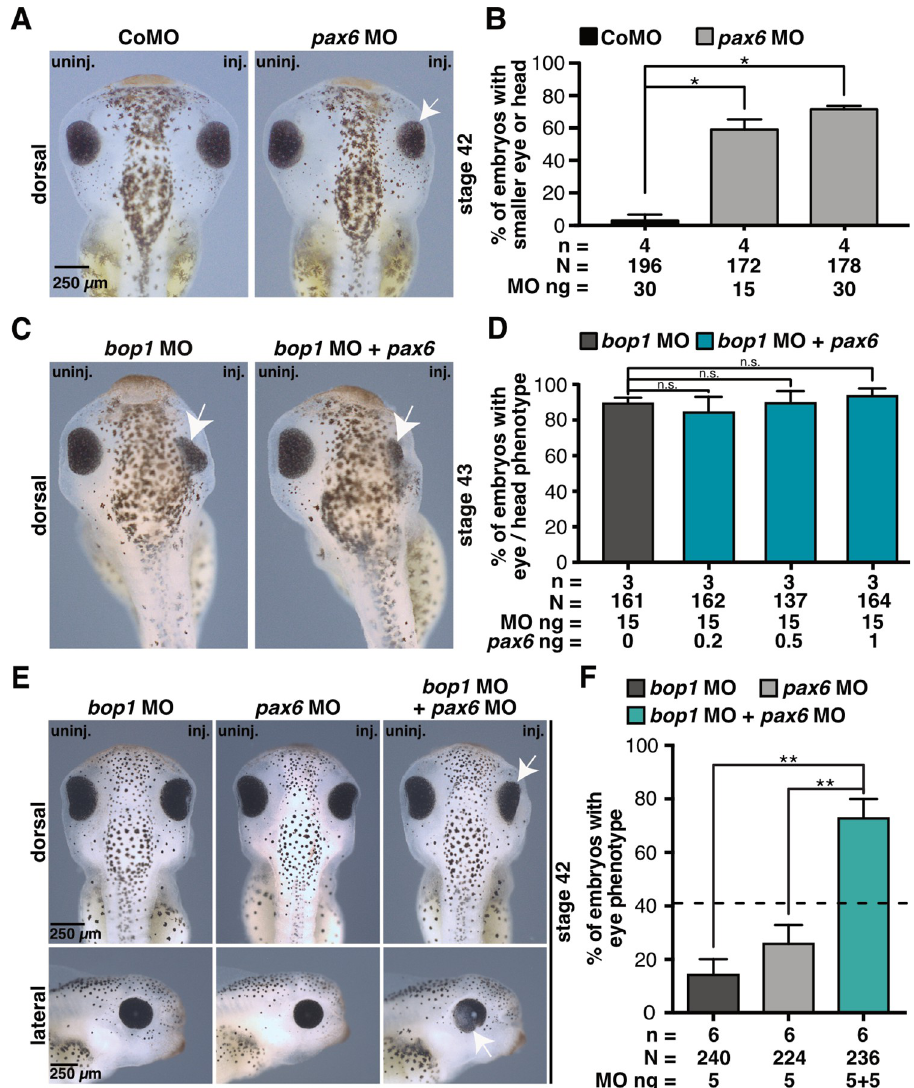
Fig 8. Pax6 and Bop1 act in the same signaling pathway. A Xenopus laevis embryos were injected with 30 ng Control MO and 15 ng or 30 ng pax6 MO at eight-cell stage into one animal-dorsal blastomere. At stage 42, embryos were analyzed regarding a phenotype of the anterior tissue. pax6 MO injection resulted in smaller heads and eyes (white arrows). B Statistical evaluation of data given in A. C Embryos were injected at eight-cell stage with bop1 MO alone or in combination with pax6 RNA. Embryos were fixed at stage 42 and analyzed phenotypically. Smaller eyes are indicated with white arrow. D Injection of bop1 MO alone or in combination with pax6 RNA resulted in severe eye phenotypes. E Injection of 5 ng bop1 MO or 5 ng pax6 MO led to a mild eye phenotype in 15% and 27% of the embryos, respectively. The co-injection of both 5 ng bop1 MO and 5 ng pax6 MO resulted in a severe eye phenotype in a more than additive manner (73%). F Statistical analysis of data given in E. Black dotted line indicates sum of embryos showing an eye or head phenotype injected with 5 ng bop1 MO and 5 ng pax6 MO. Abbreviations: bop1 MO, block of proliferation 1 morpholino oligonucleotide; CoMO, Control MO; inj., injected side; MO, morpholino oligonucleotide; n, number of independent experiments; N, number of injected and analyzed embryos; n.s., non-significant; pax6 MO, paired box 6 morpholino oligonucleotide; uninj., uninjected side. Error bars indicate standard error of the means; � , p � 0.05; �� , p �